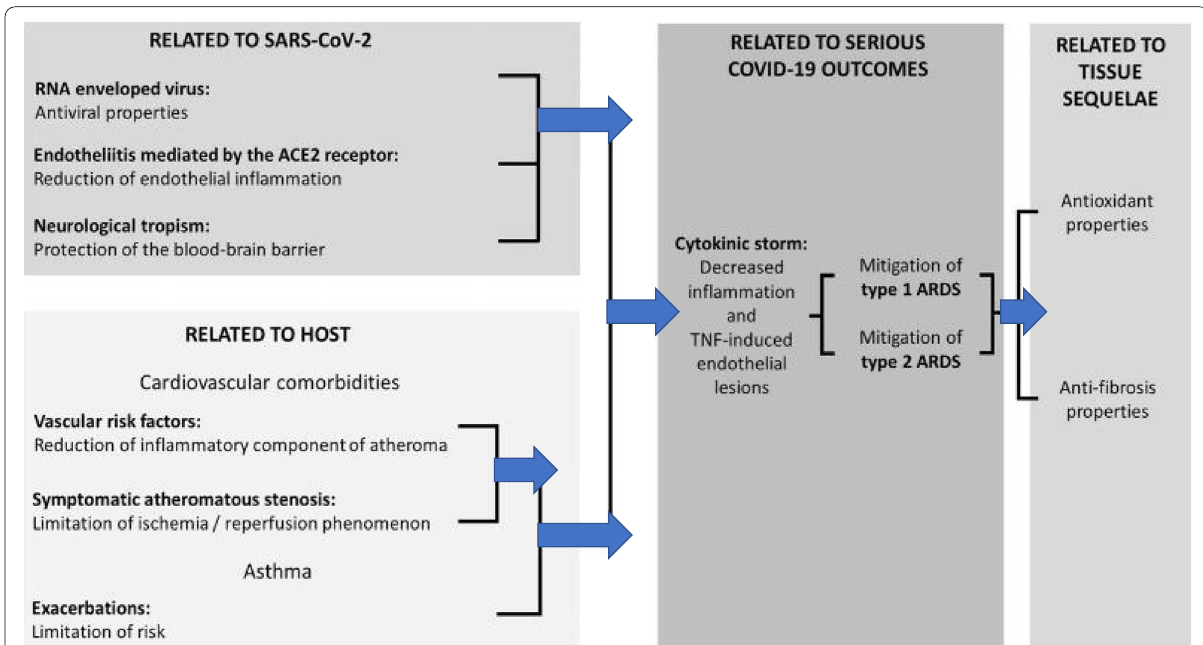
Fig. 1 Experimentally supported properties of cyst LT1 receptor antagonists potentially beneficial in COVID‑19 (adapted from Barré et al.